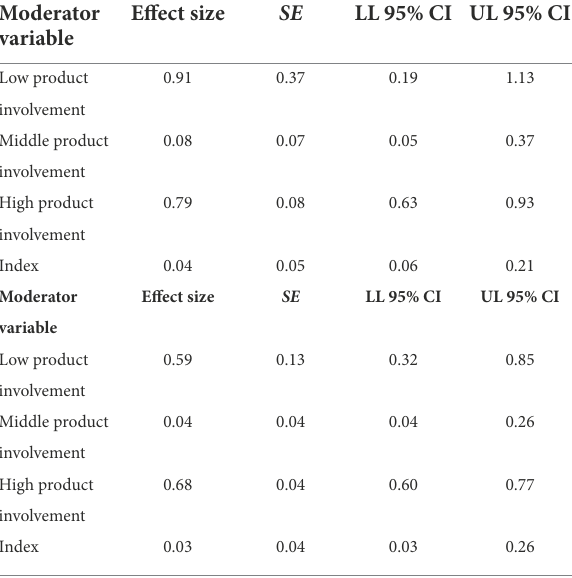
TABLE 6 Results for the effect of CPEC on consistency purchase intention across levels of product involvement.